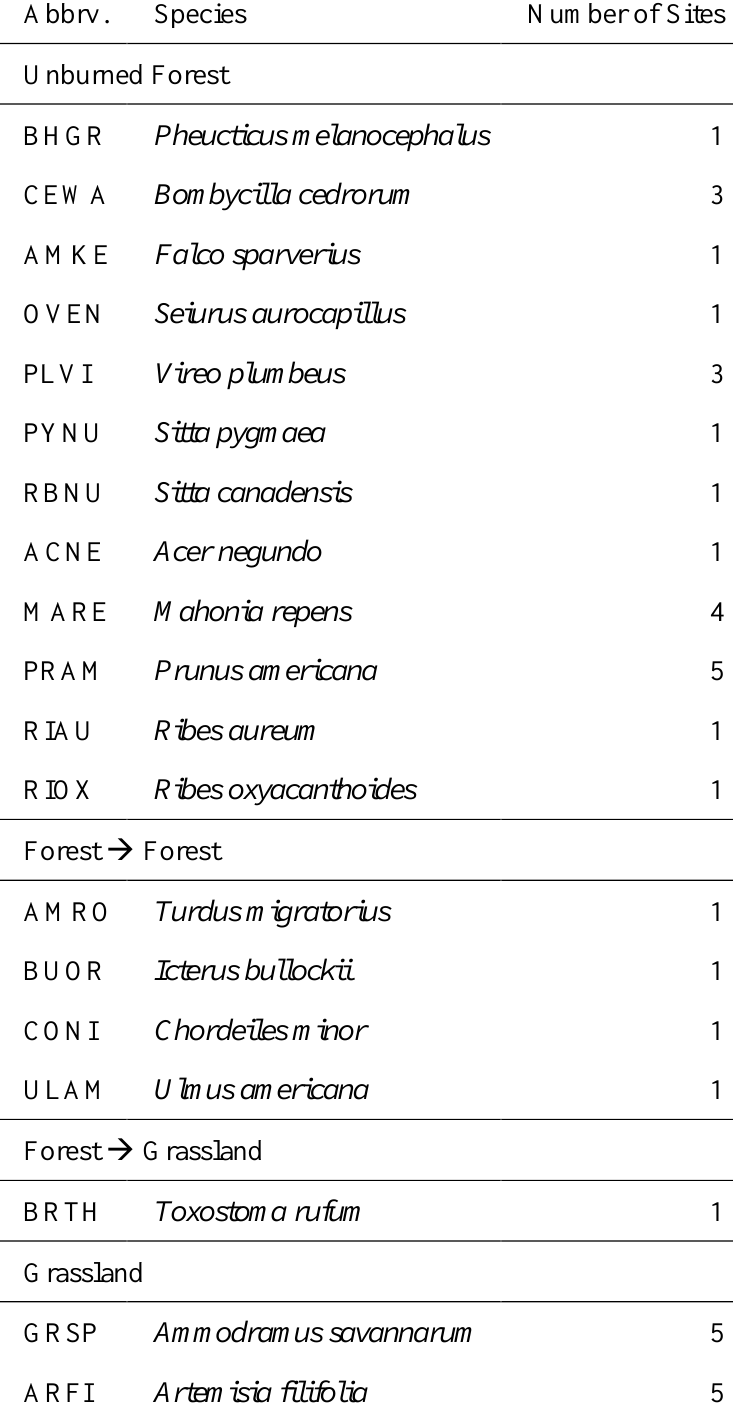
Table A1.6. A list of understory woody plant and bird species unique to each transition class, along with the number of sampling sites each species was recorded in.